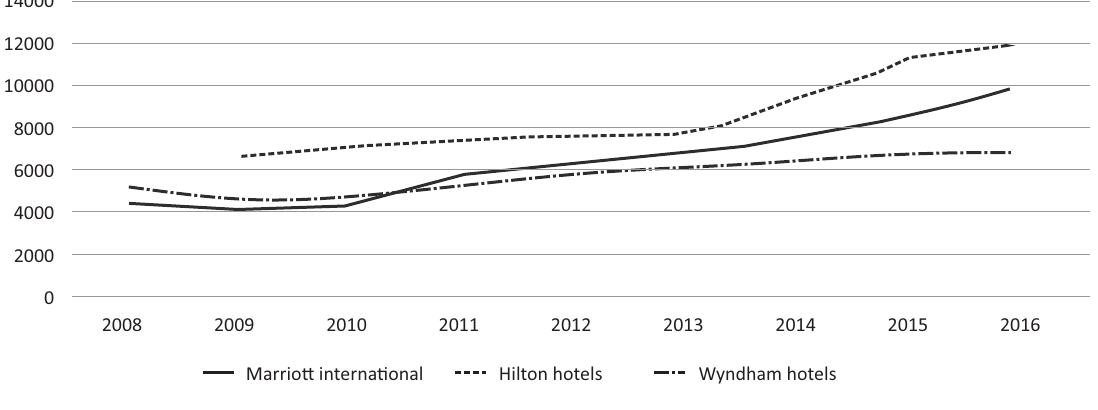
Figure 4. Dynamics of income from franchise payment in hotel chains in 2008–2016